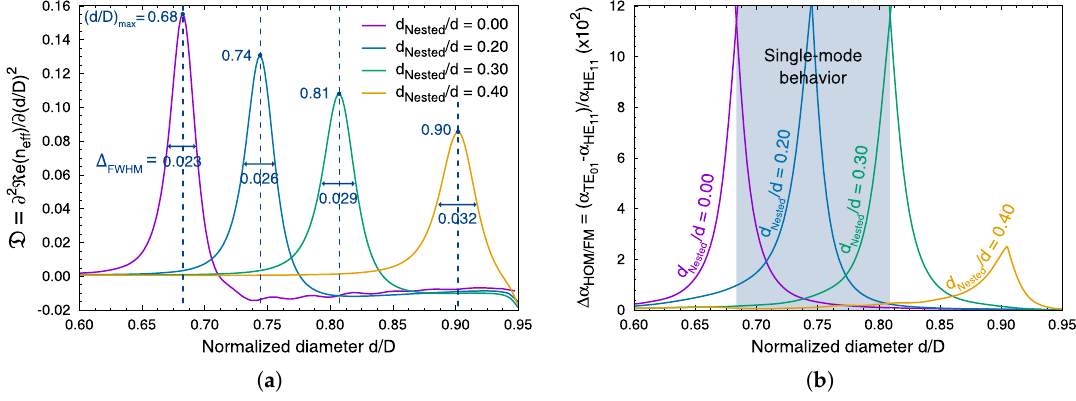
Figure 3. ( a ) Effective index dispersion of the TE + hybrid mode as a function of normalized diameter 01 d / D , for four different values of parameter d Nested / d ; ( b ) Numerically calculated degree of HOM suppression, plotted against d / D using the simulated confinement losses above. The gray-shaded area shows the region where NANFs tend towards a single-mode